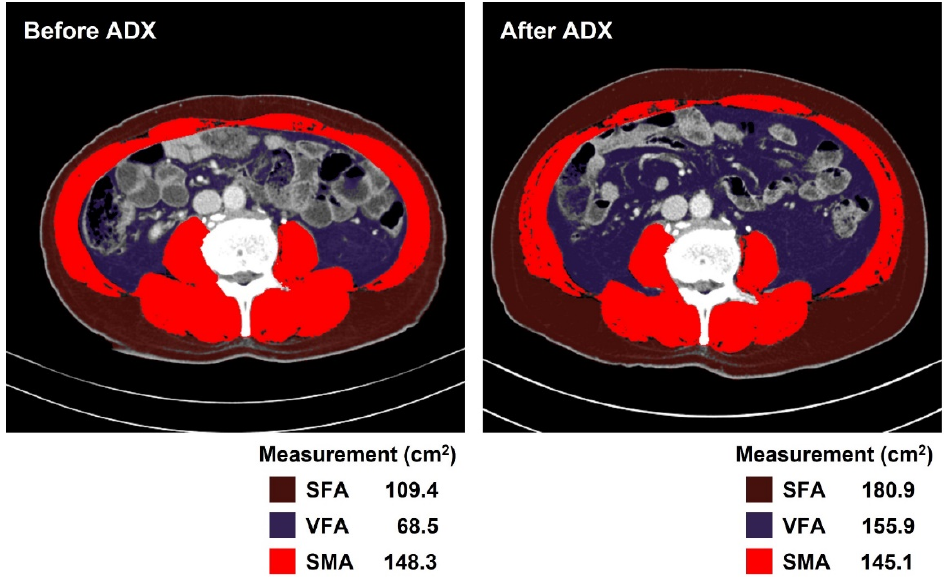
Figure 2. Representative image for body composition measurement using automated artificial intelligence software AID-U TM (iAID inc, Seoul, Korea). Subcutaneous fat area (SFA; brown) and visceral fat area (VFA; purple) increased following adrenalectomy (ADX), whereas skeletal muscle area (SMA; red) statistically remained unchanged. These findings were observed in 266 out of 313 patients